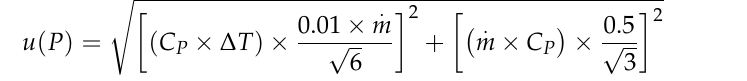
Figure 3. Picture of the testing rig installed at ITAE lab ( left-hand side ) and hybrid TES system